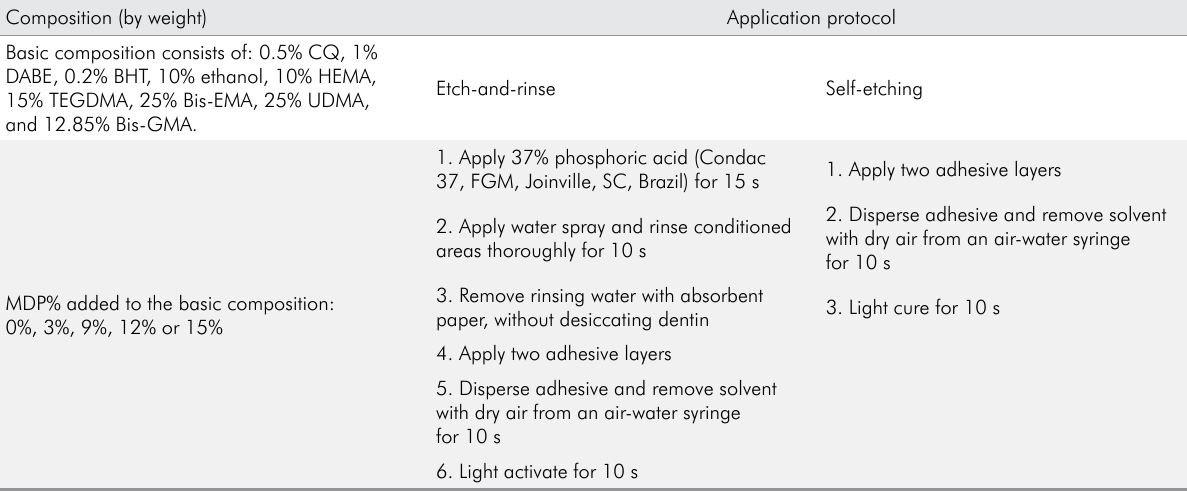
Table 1. Composition of the experimental adhesives. Composition (by weight) Application